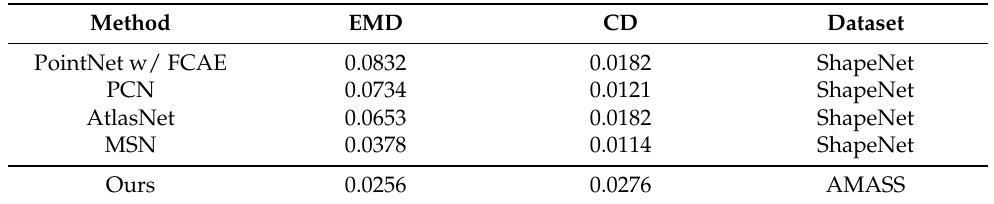
Figure 6. Distribution of Earth Movers Distance and Chamfer Distance values. Box shows 95% of values are between 2.5% and 97.5% percentiles of values. Table 5. Reconstruction metric comparison between other methods and ours. While direct com- parison cannot be drawn due different datasets and techniques being adopted we can see that the reconstruction values are at least very similar to state-of-the-art when compared to ShapeNet dataset. As per Liu et al. (2020) reference